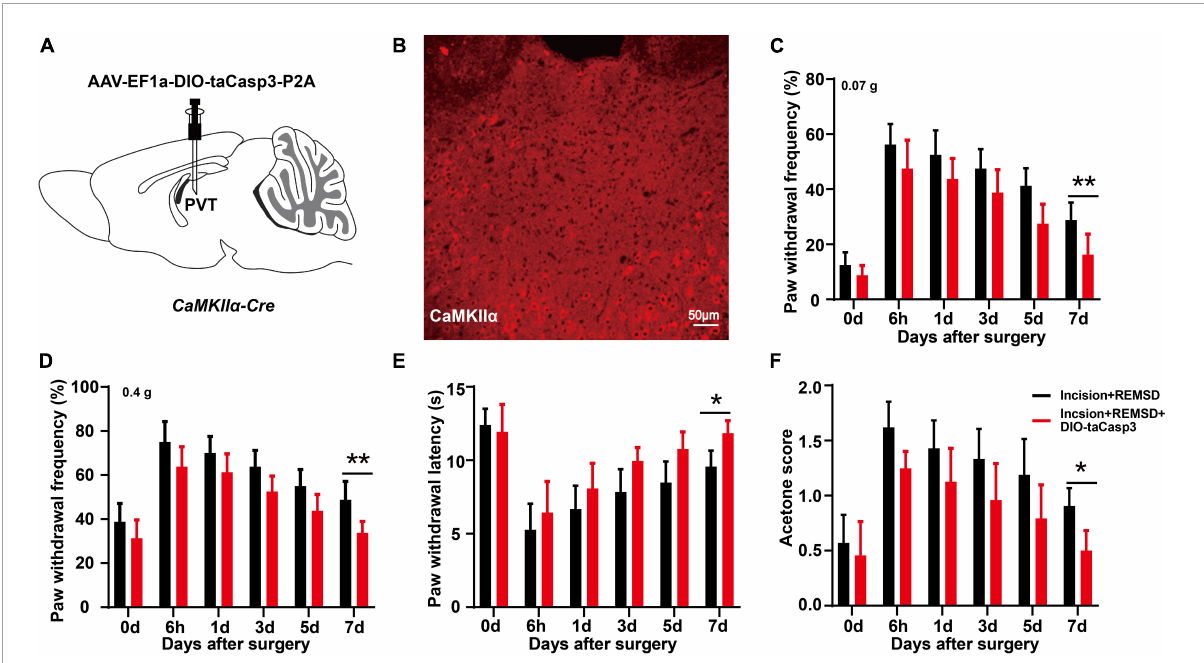
FIGURE4 Ablation of PVT CaMKII α eliminates the prolonged postsurgical pain induced by rapid eye movement sleep deprivation (REMSD). (A) Experimental configuration showing AAV-EF1a-DIO-taCasp3-P2A injection into the mPVT of CaMKII α -Cre mice. (B) Image showing CaMKII α -positive neurons in the middle paraventricular thalamus (mPVT) at 21 days after taCasp3 administration. (C,D) Mechanical paw withdrawal frequency in response to 0.07 g von Frey (C) and 0.4 g von Frey (D) at different time points. (E) Paw withdrawal latency in response to thermal stimulus at different time points. (F) Measurements of cold sensitivity by acetone testing. Significance was assessed by two-way ANOVA with post hoc multiple comparisons between groups in panels (C–F) . Incision + REMSD vs. incision + REMSD + DIO-taCasp3; n = 8. * P < 0.05, ** P < 0.01, scale bar: 50 µ